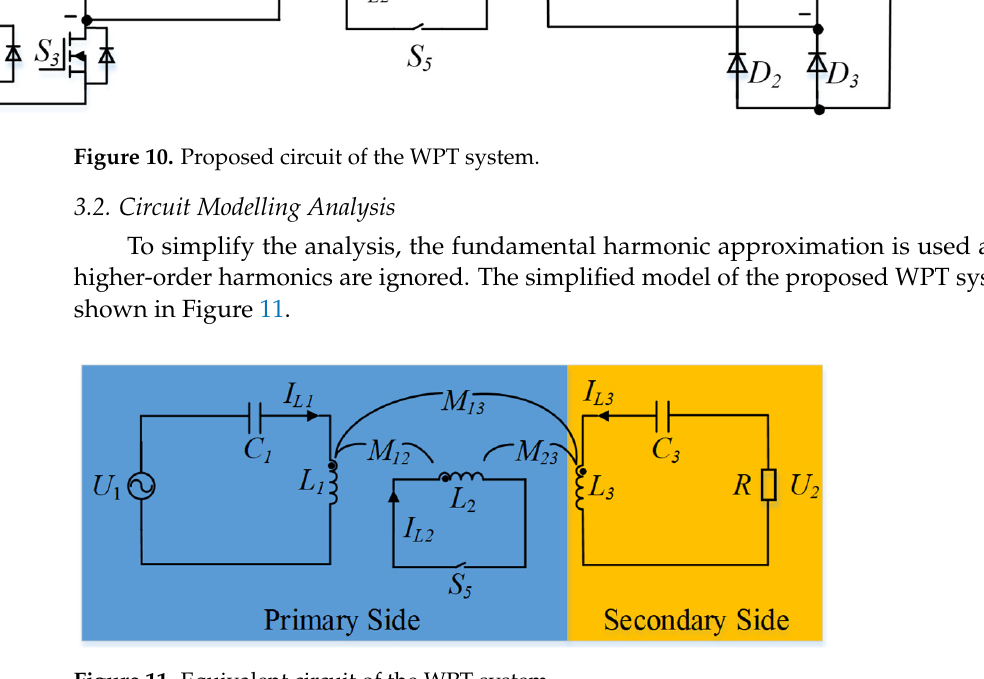
Figure 11. Equivalent circuit of the WPT system.